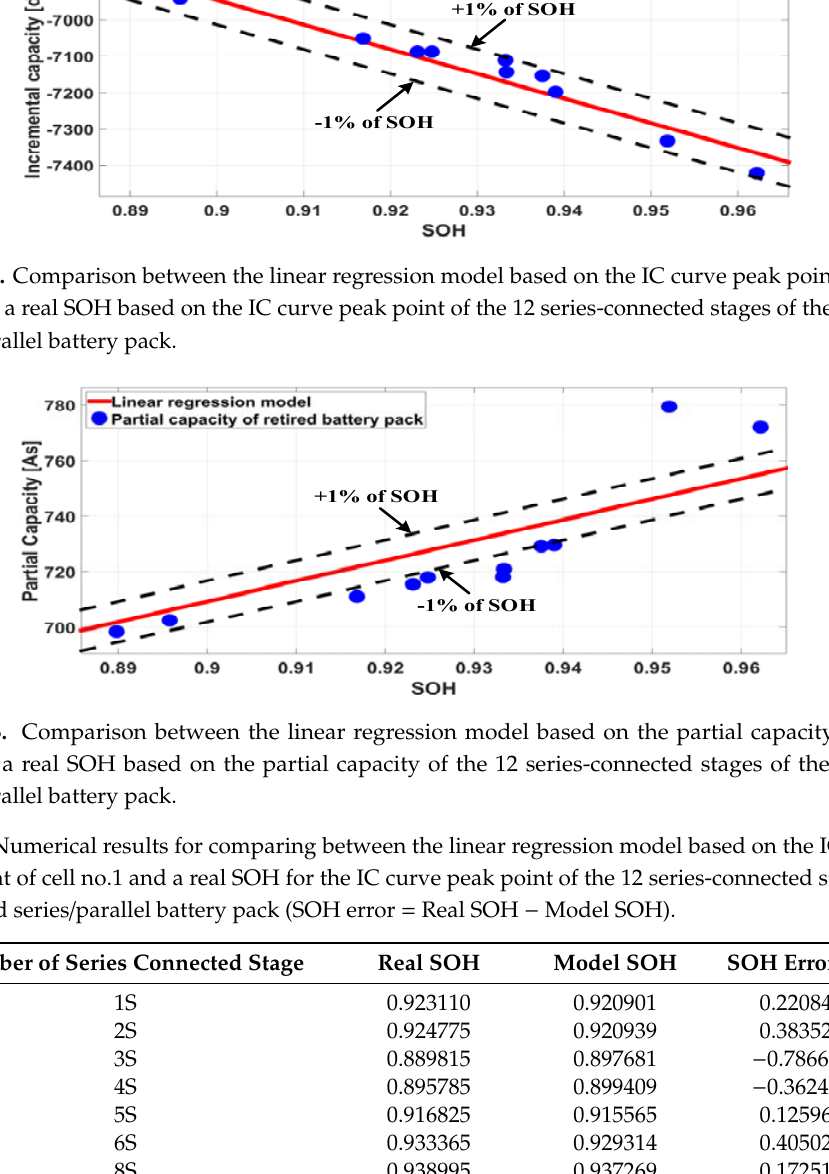
Figure 24. Comparison of two SOH errors (SOH error = Real SOH − Model SOH) between the linear regression model SOH (cell no. 1) and a real SOH (12 series ‐ connected stages of the retired series/parallel battery pack) considering the IC curve peak point and partial capacity. Table 3. Numerical results for comparing between the linear regression model based on the IC curve peak point of cell no.1 and a real SOH for the IC curve peak point of the 12 series ‐ connected stages of the retired series/parallel ba tt ery pack (SOH error = Real SOH − Model SOH). Number of Series Connected Stage Real SOH Model SOH